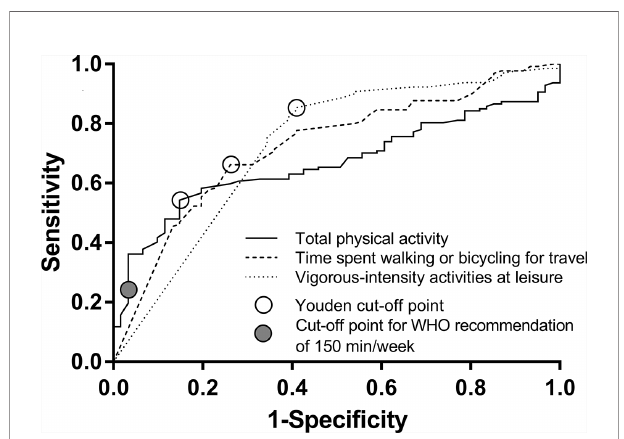
FIGURE 1 | The results of the Receiver Operating Characteristic analysis with open circles indicating Youden's cut-off